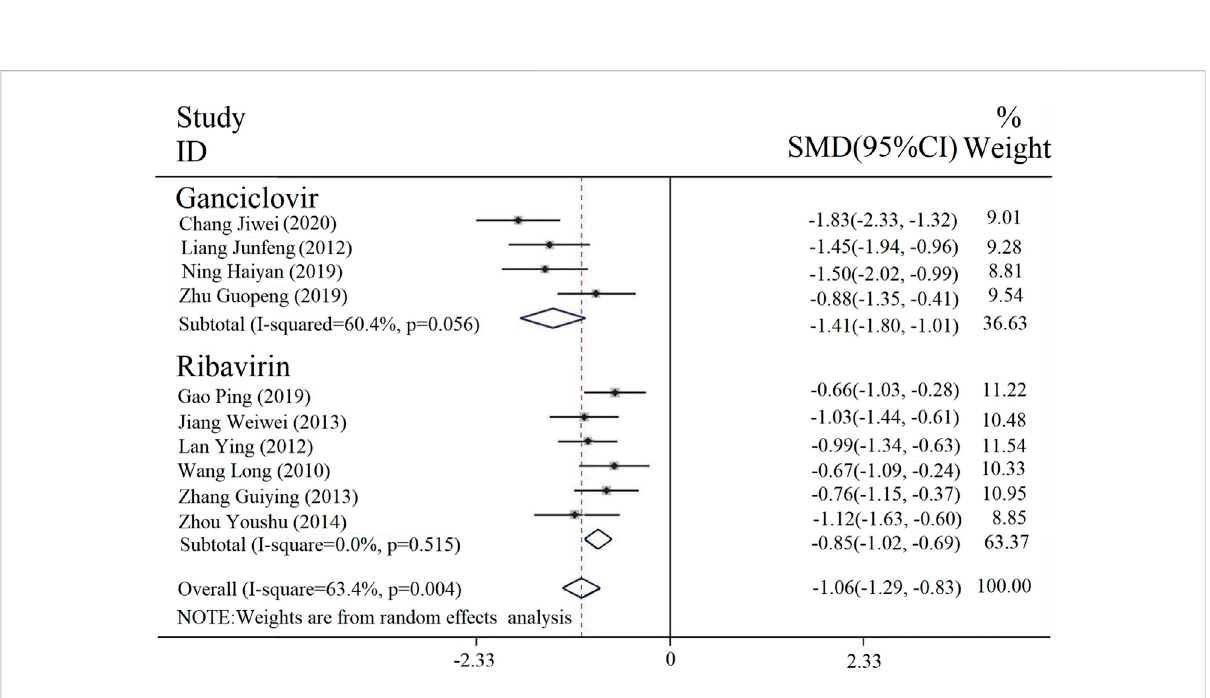
FIGURE 4 Forest plot of duration of fever comparison among